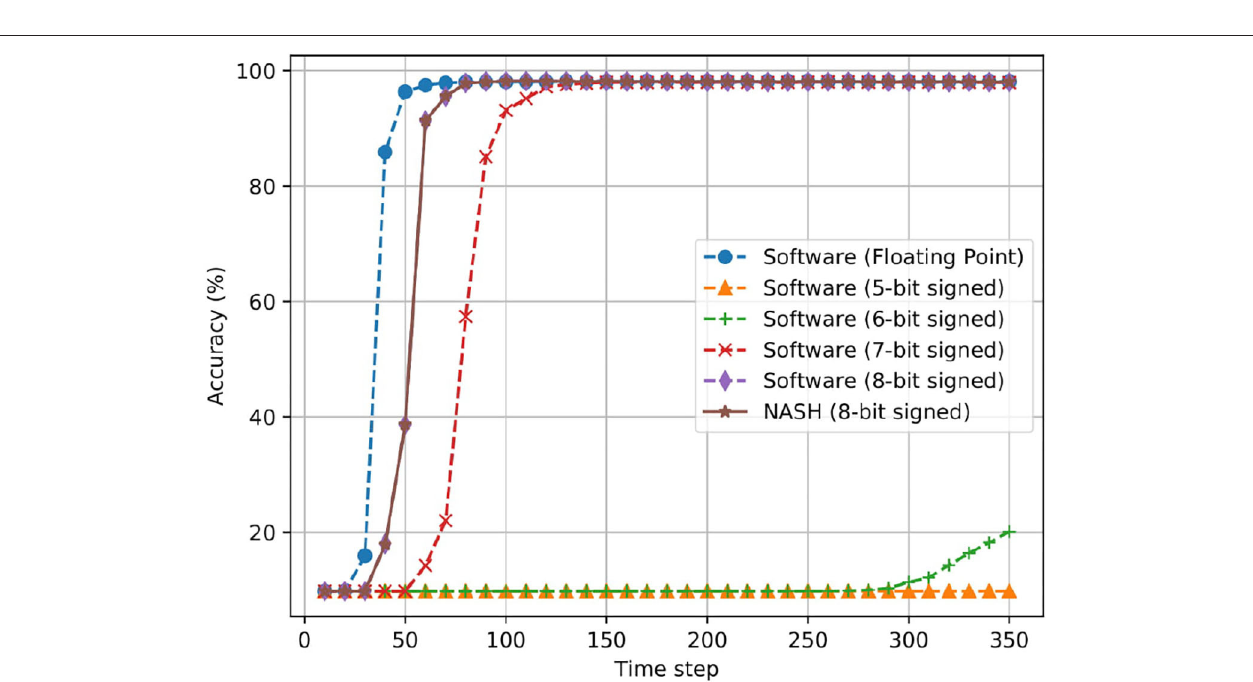
FIGURE 18 | Accuracy result of offline training for MNIST dataset with the network model 784:1024:1024:1024:10.